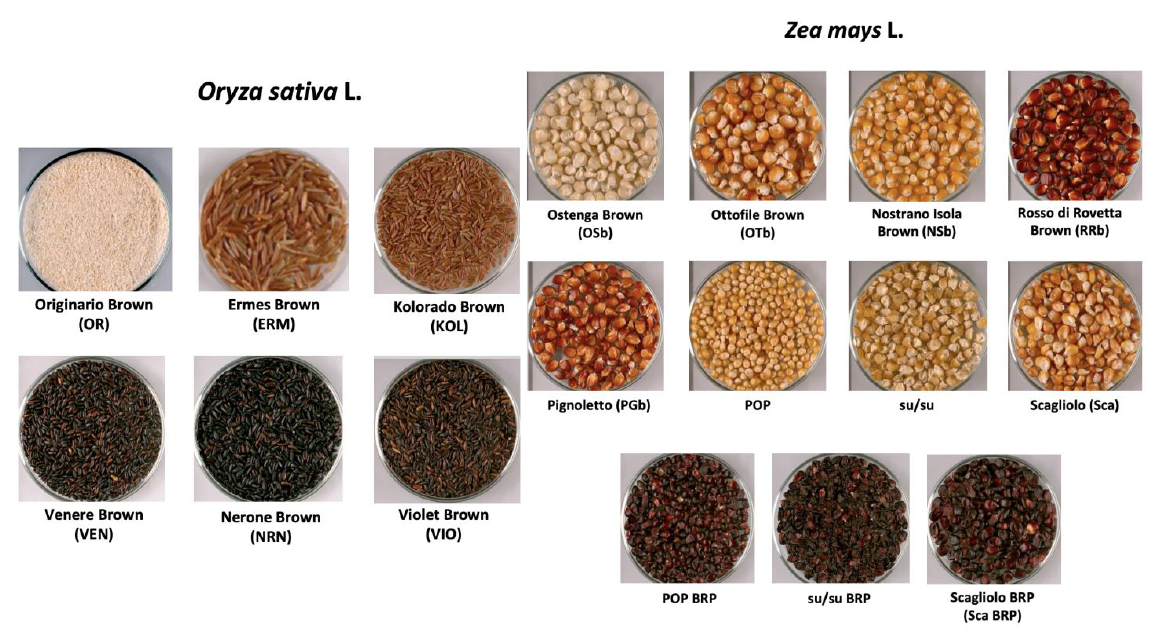
Figure 6. Rice and corn samples included in this study.